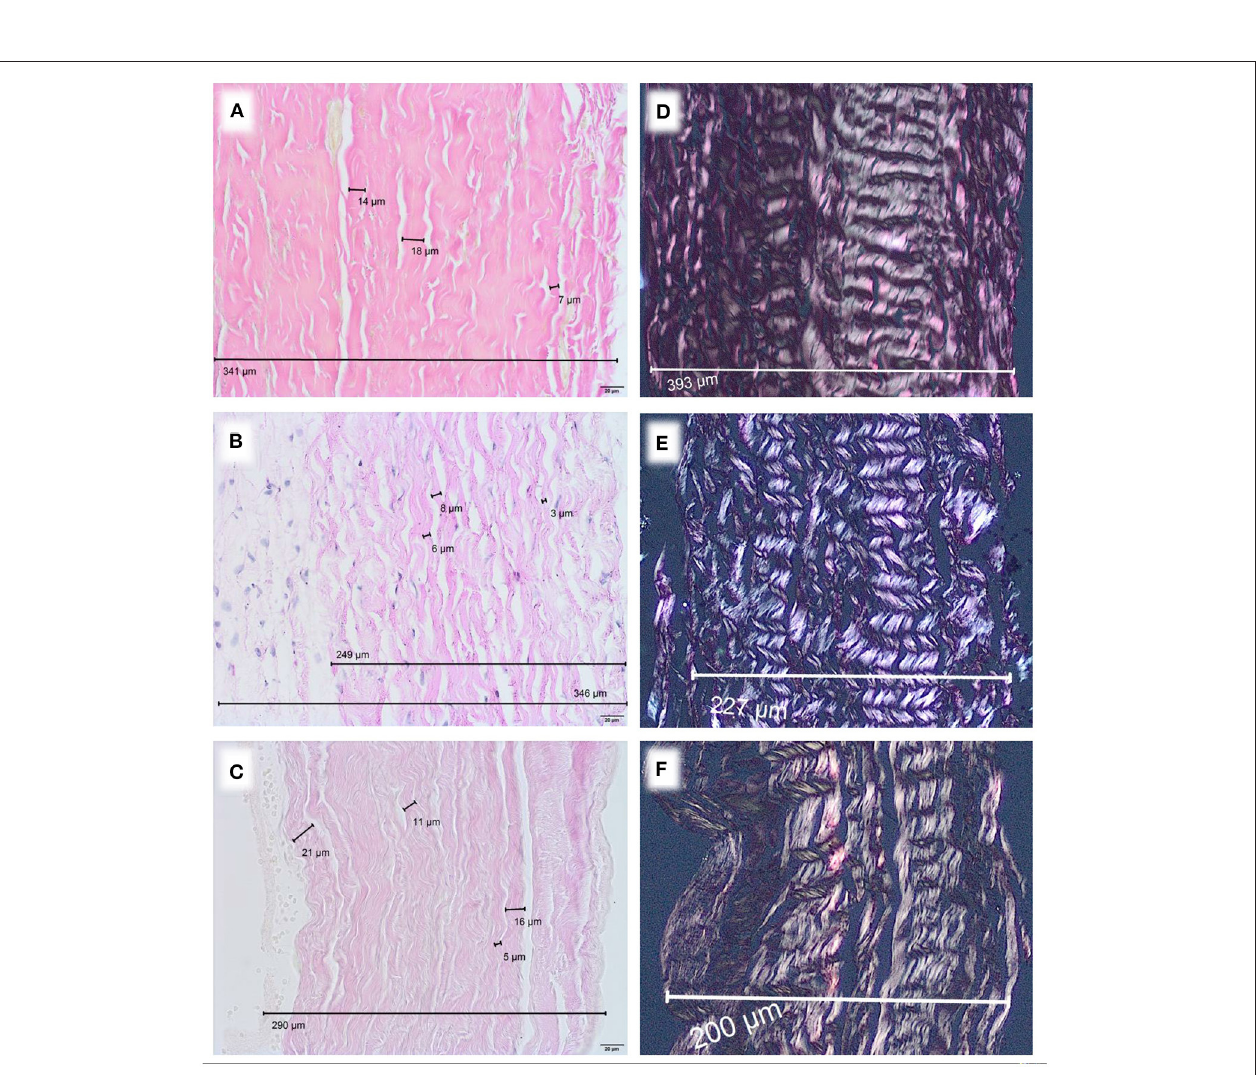
FIGURE 2 | Native pericardium of different species, EvG staining, Obj. 40x, (A) bovine, (B) porcine, (C) equine. Polarization, EvG staining, Obj. 20x, (D) bovine, (E) porcine, (F) equine.